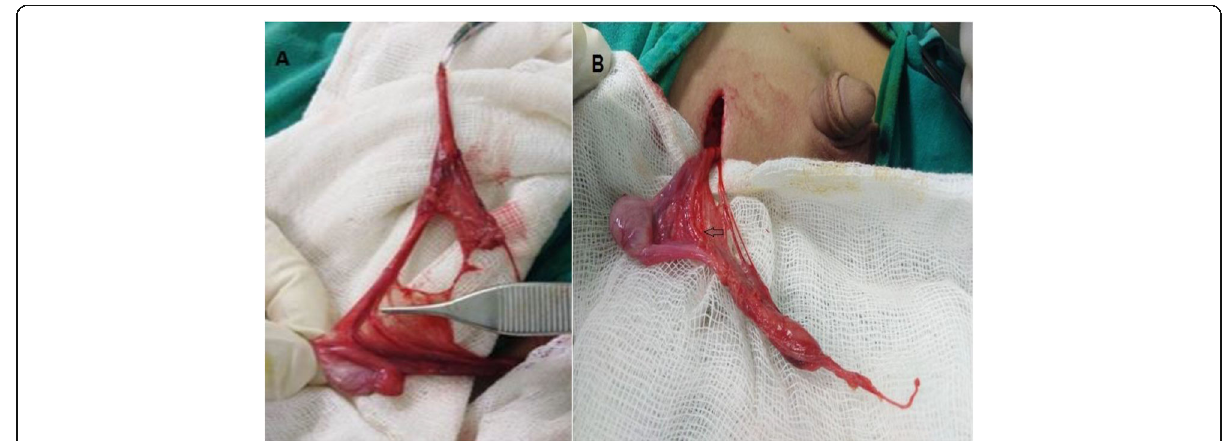
Fig. 2 a congenital long looping epididymis and looping vas deferens. b Another view